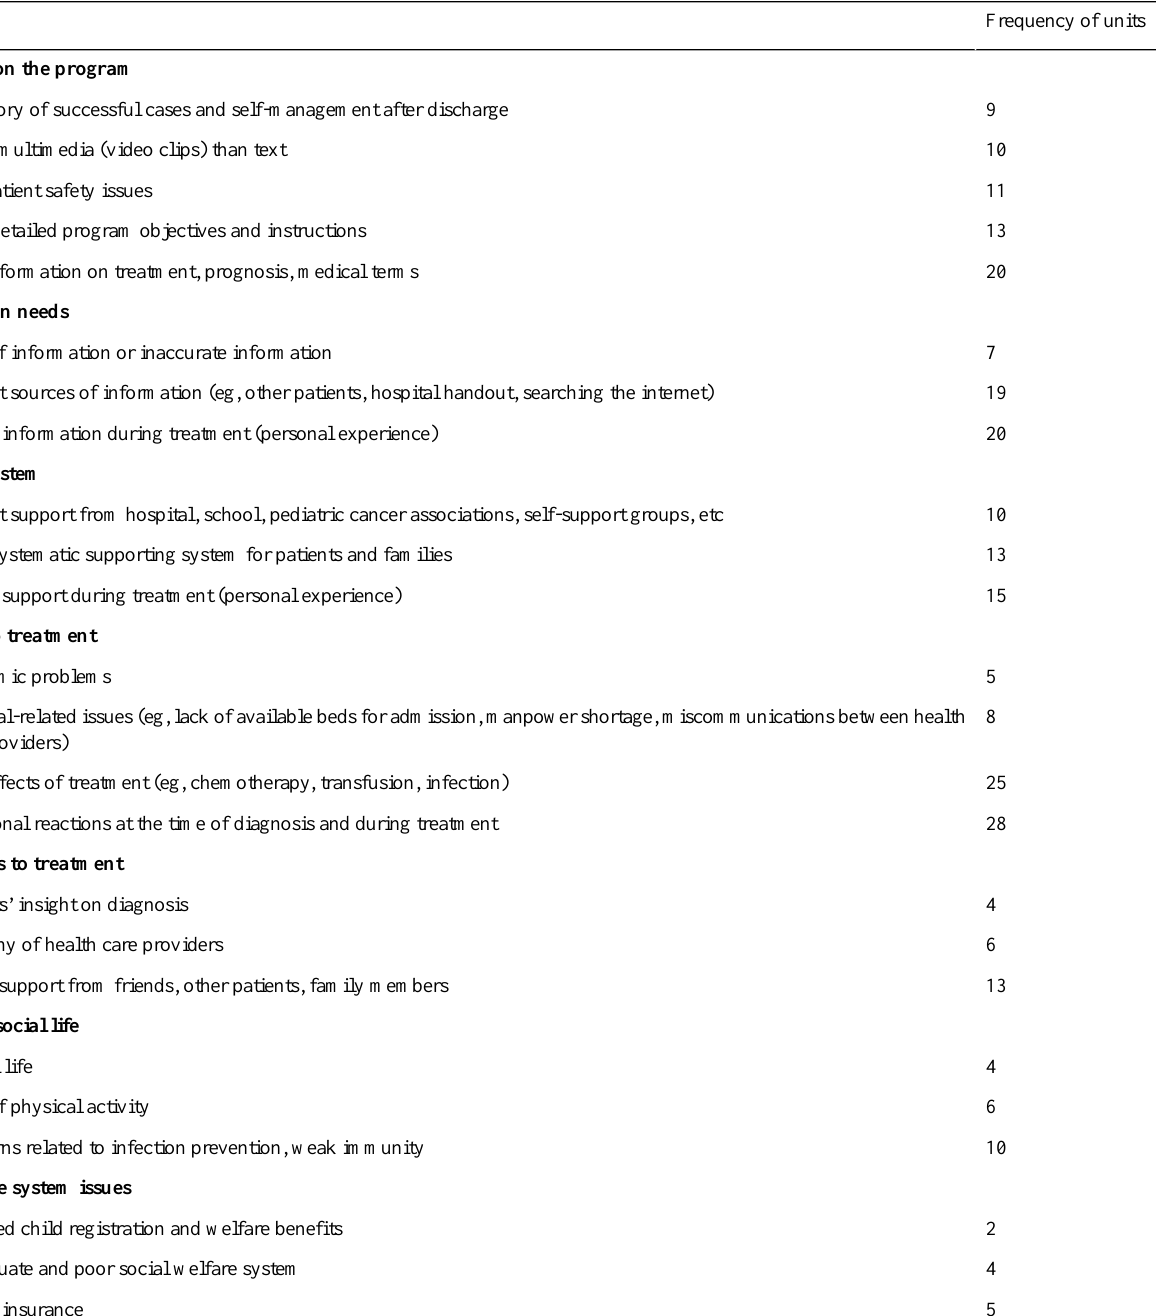
Table 2. Content analysis of focus group discussion transcriptions